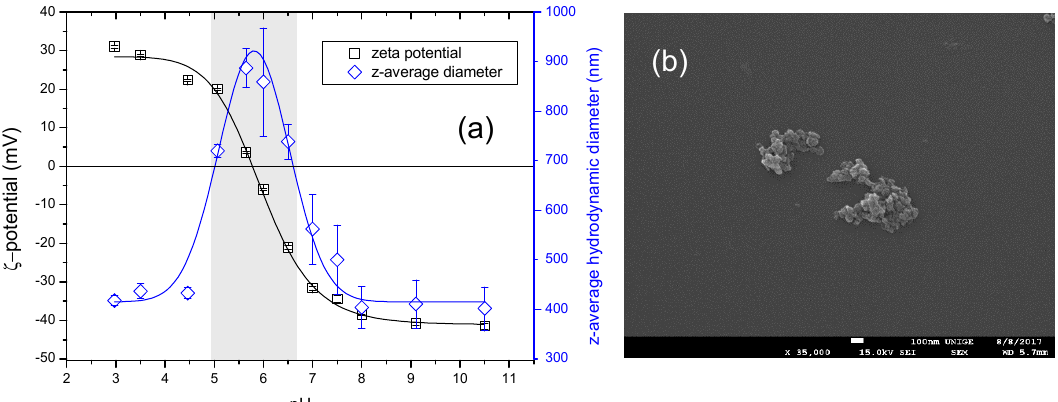
Figure 1. ( a ) Zeta ( ζ ) potential and z-average hydrodynamic diameter variation of TiO 2 nanoparticles (NPs) (10 mg/L) as a function of pH in ultrapure water. The point of zero charge (PZC) is found at pH pzc = 5.8 ± 0.1. Aggregation is observed in the PZC region (gray domain) ( b ). SEM image of TiO 2 NPs in ultrapure water at pH > pH pzc . Aggregates diameters are found consistent with dynamic light scattering (DLS) analysis. Lines connecting data are given to guide the eye.